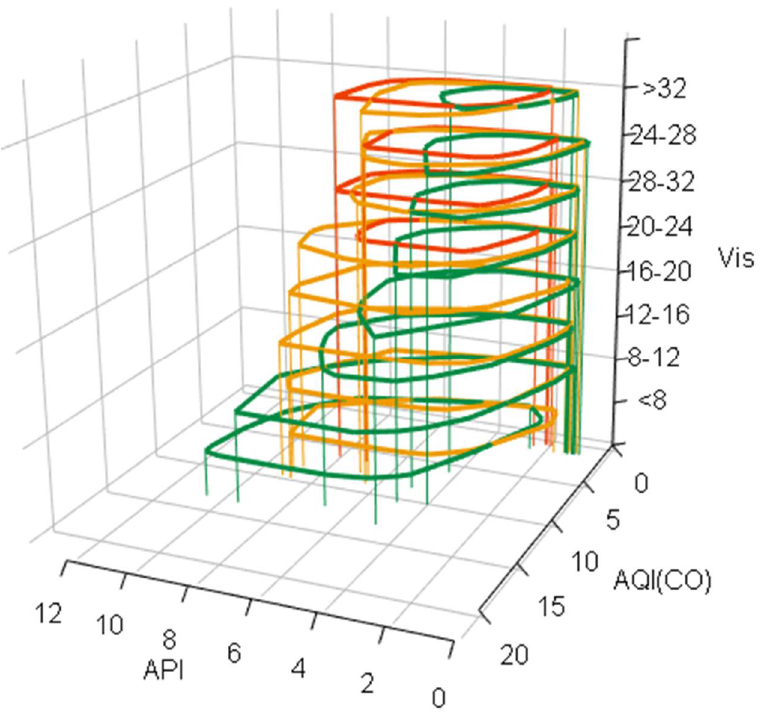
Figure A13. Effect of visibility-dependent CO air concentration on the air pollution index for the rainy season in spring, summer and winter.